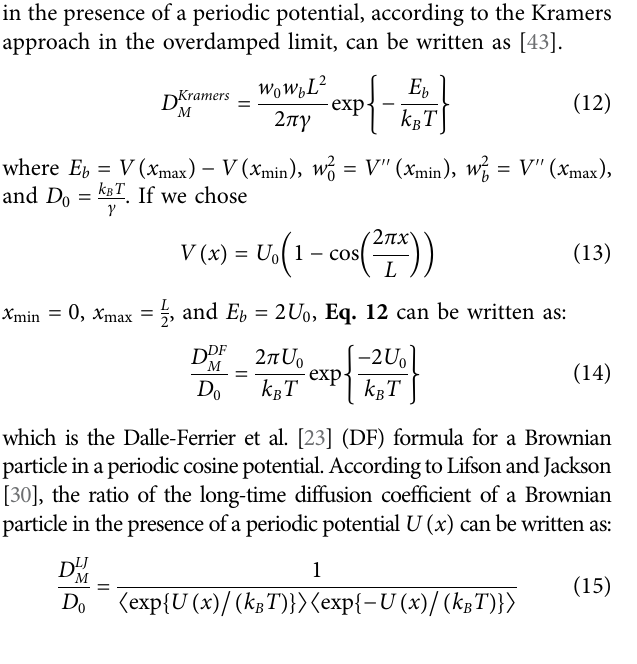
Frontiers in Physics |